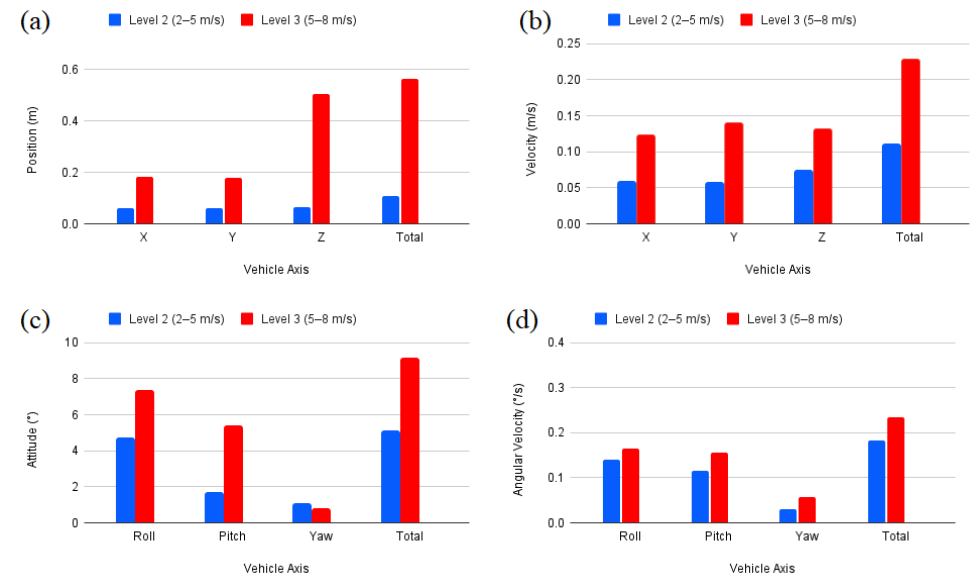
Figure 12. RMSE comparison between wind-still and windy conditions for Tarot X4. All values are with respect to a set point. ( a ) RMSE on position. ( b ) RMSE on velocity. ( c ) RMSE on attitude. ( d ) RMSE on angular